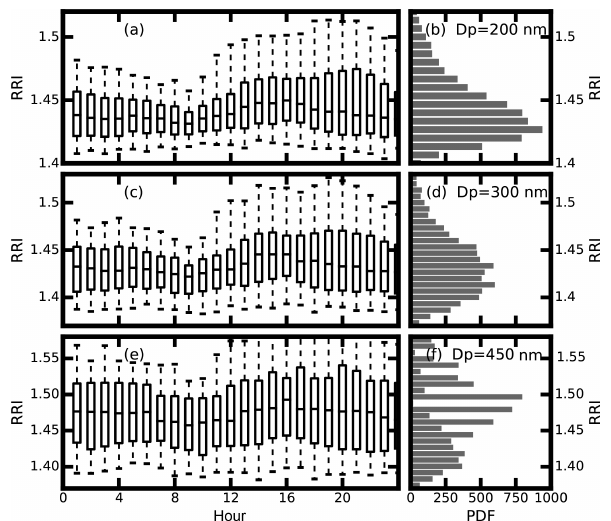
Figure 6. Daily variations of the RRI (a, c, e) and the probabil- ity distribution of the measured RRI (b, d, f) for (a, b) 200nm, (c, d) 300nm and (e, f) 450nm aerosol. The box-and-whisker plots represent the 5th, 25th, 75th and 95th